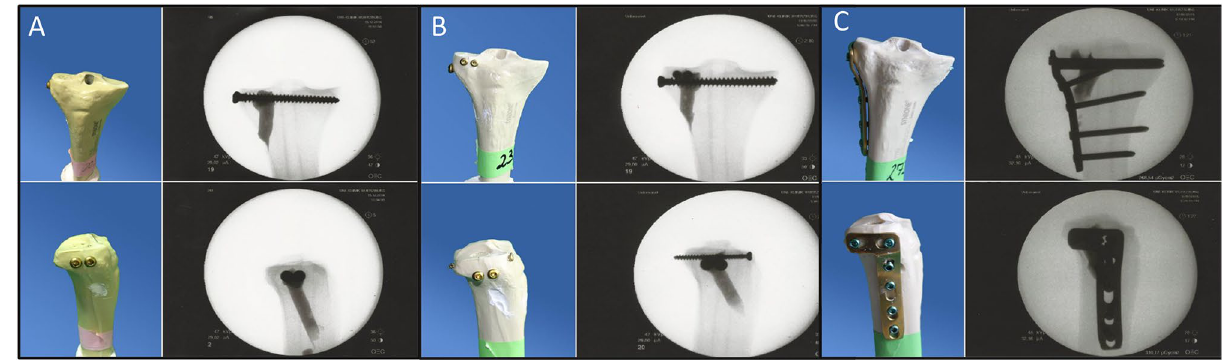
Figure 2. Overview of the different treatment groups. After reduction, the lateral tibial depression fractures were stabilized with three different types of osteosyntheses alone and in combination with bone cement: 2 screws ( A ), 4 screws in the jail or raft technique ( B ) and lateral angle-stable buttress plate ( C ). Specimens and the corresponding x-rays before testing are demonstrated for every osteosynthesis group with bone